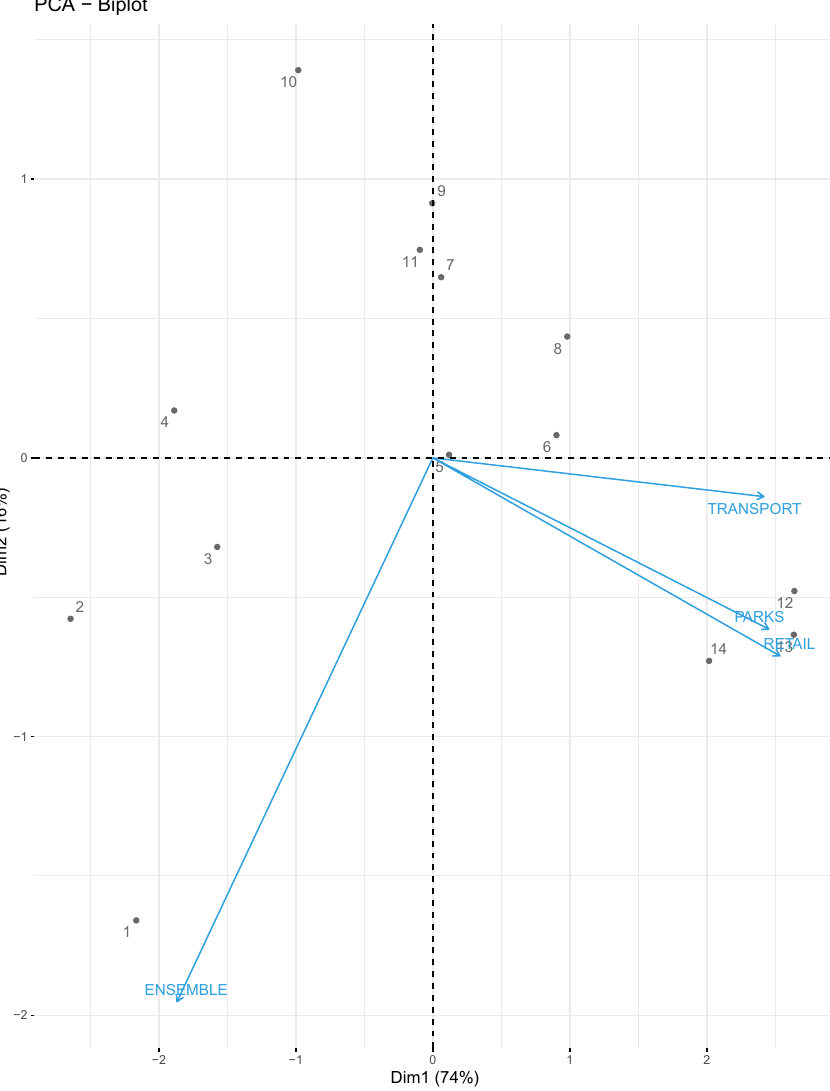
Figure 5. PCA to ensemble approach and mobility variables. Positively correlated variables point to the same side of the plot. Negatively correlated variables point to opposite sides of the